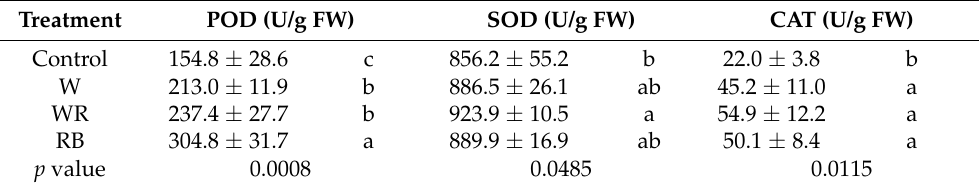
Table 5. The activities of the antioxidant enzymes of the greenhouse-grown tomato seedlings grown under supplementary white LEDs, white plus red LEDs, and red plus blue LEDs, respectively, and tomato seedlings grown under sunlight only were regarded as the control.